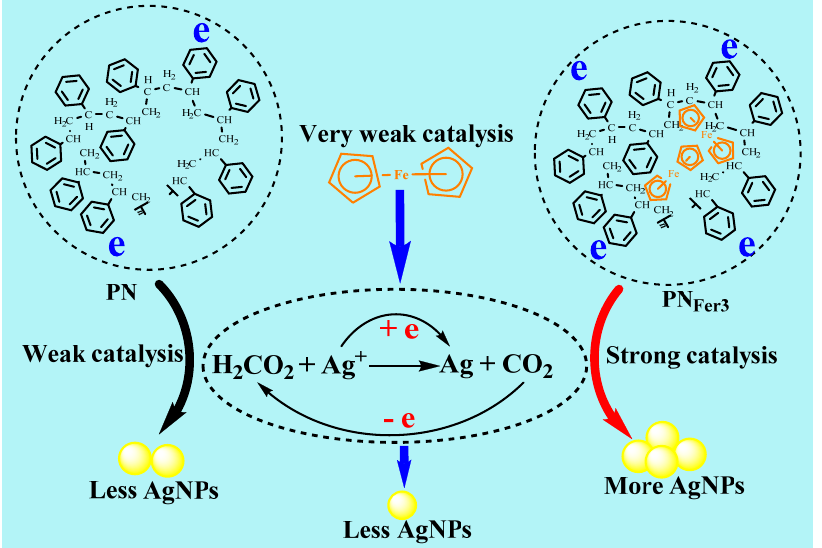
Figure 8. Comparison of polystyrene nanosphere (PN), Fer and ferrocene ‐ doped polystyrene nanosphere (PN Fer3 ) nanocatalysis of AgNO 3 ‐ SF reaction to form AgNPs.